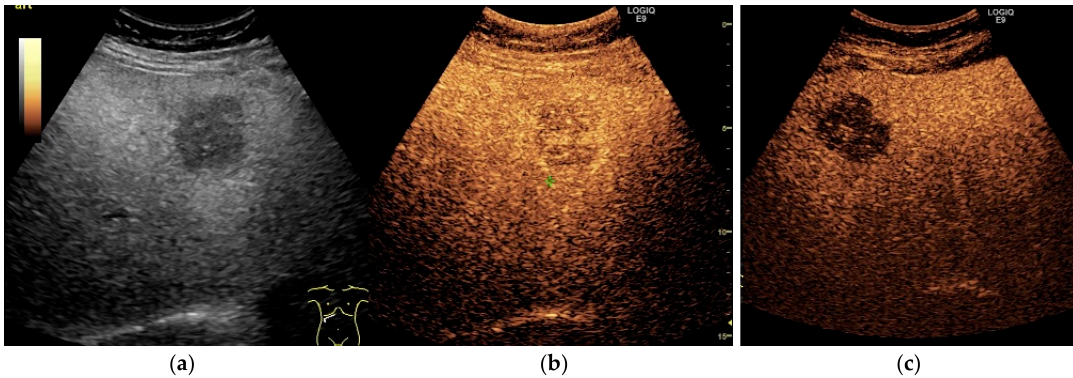
Figure 3. Hepatic steatosis. HCC. Conventional B-mode image ( a ), CEUS in the arterial phase ( b ), and CEUS in the late phase ( c ). The examination shows an enlarged liver with markedly increased echogenicity and a focal parenchymal lesion with decreased echogenicity ( a ). At CEUS technique, the lesion shows enhancement in the arterial phase ( b ), followed by washout in the late phase ( c ).